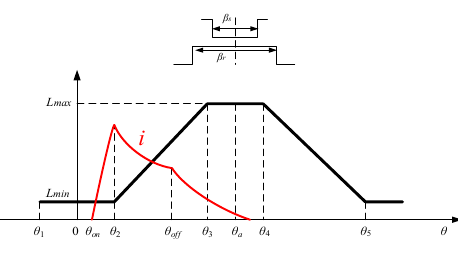
Figure 3. Typical current of phase-A.